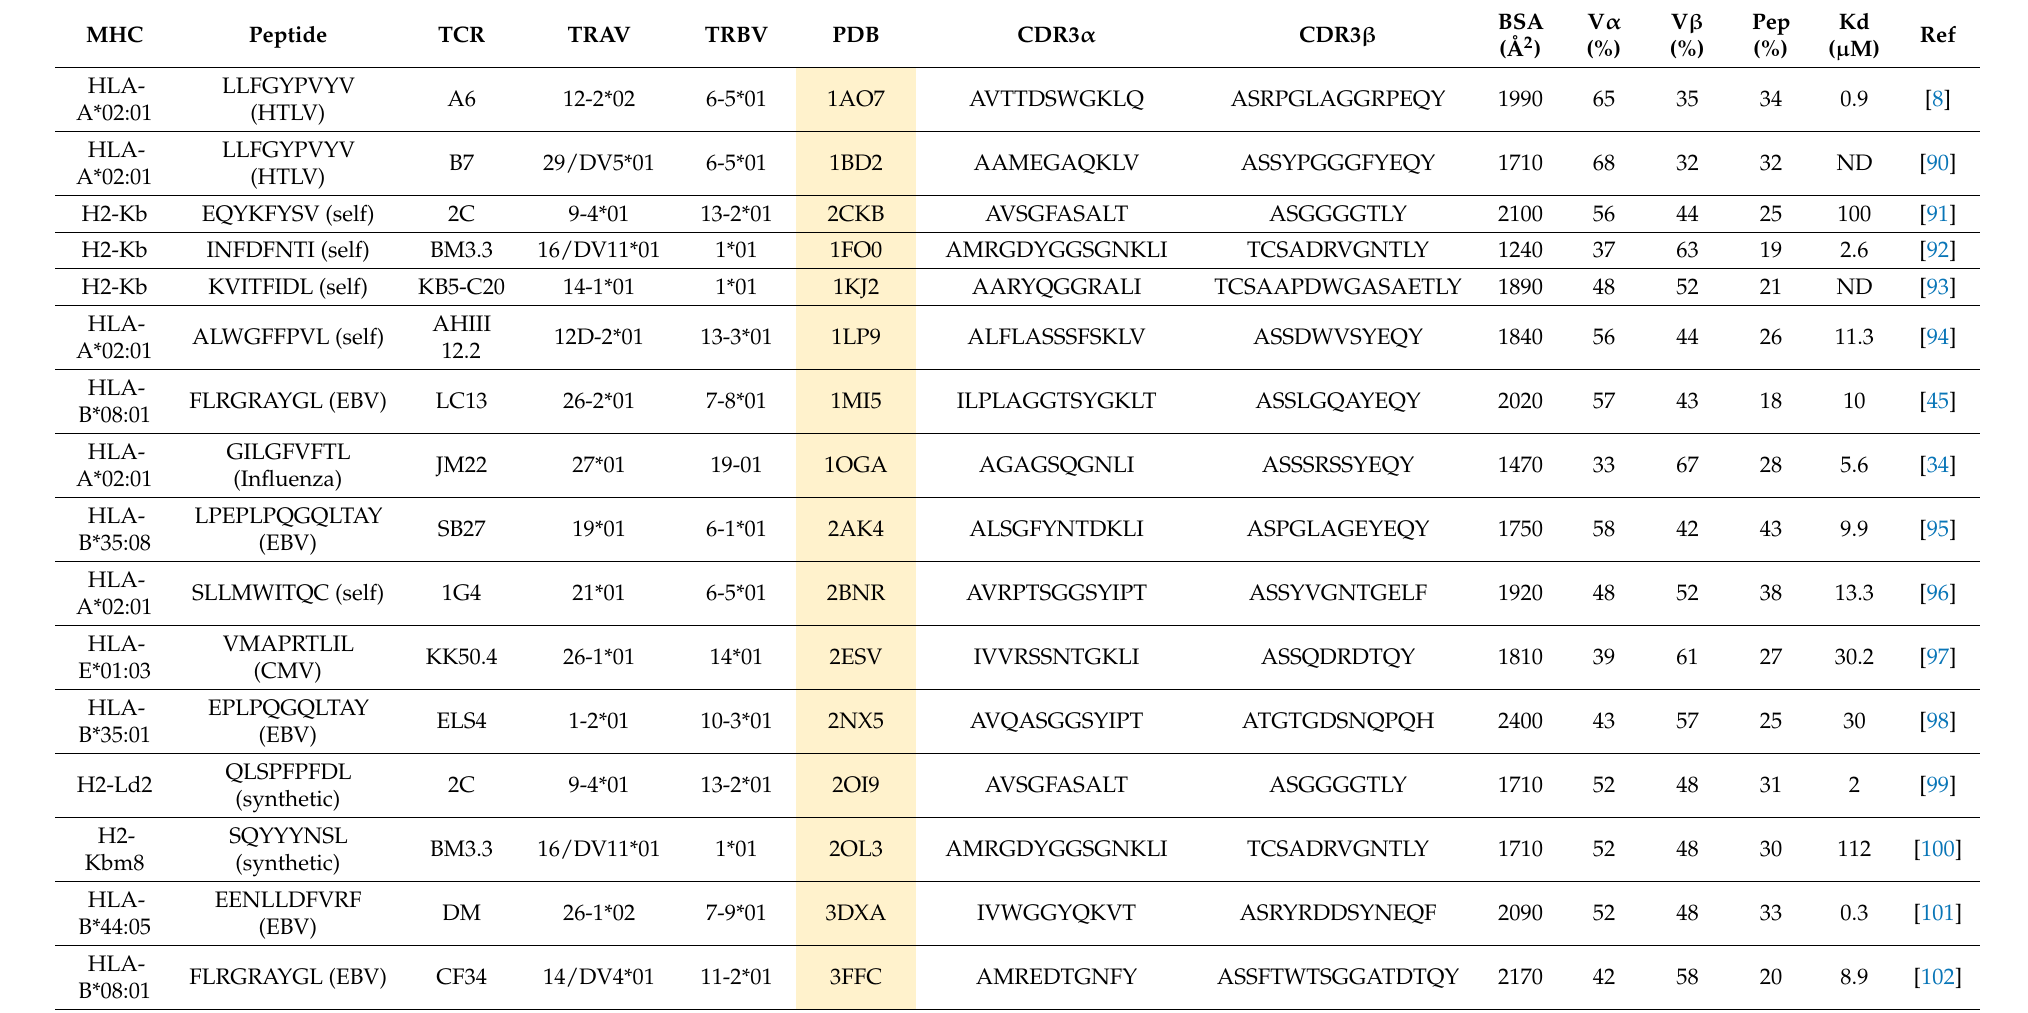
Table 1. All unique TCR–pMHC-I structures